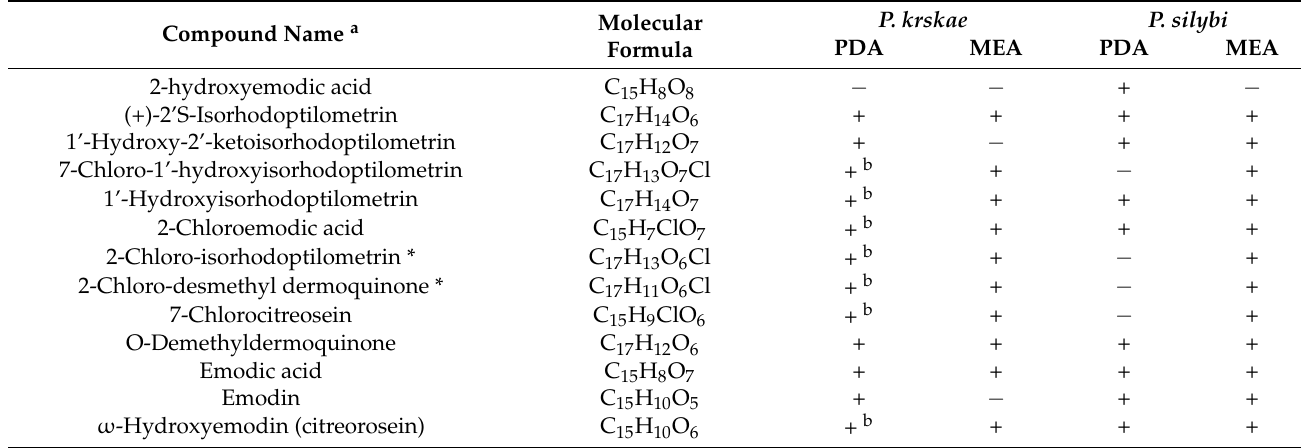
Table 4. Metabolic composition of red exudate produced by two novel Penicillium species on MEA and PDA after 7 days of cultivation at 25 ◦ C, as identified by LC–MS (El-Elimat et al., 2013, Paguigan et al.,